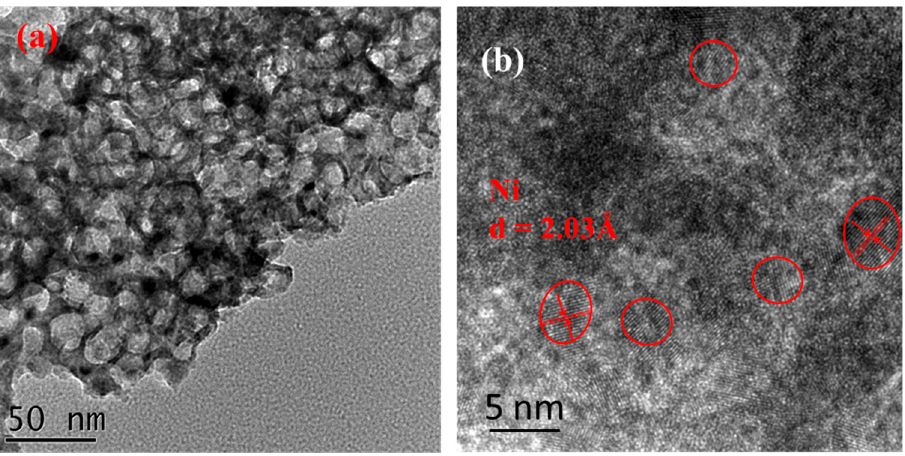
Figure 7. TEM images of the catalysts after stability test: ( a , b ) 50% Ni–La 2 O 3 –M and ( c , d ) 50% Ni–La 2 O 3 .